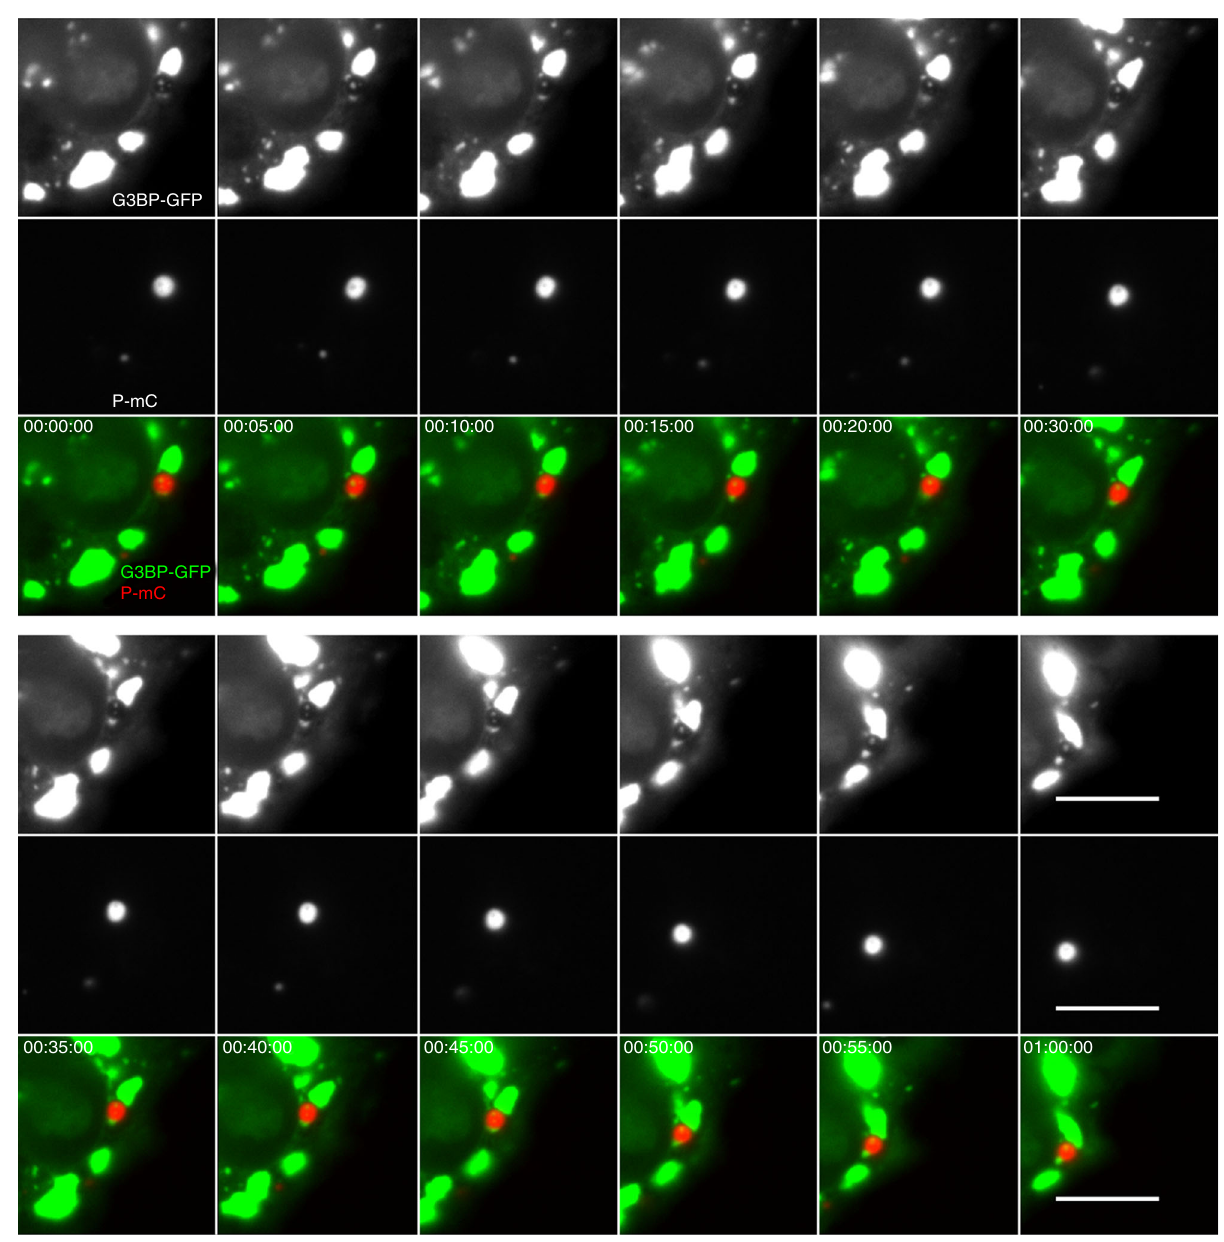
Fig. 3 NBs and SGs are non-miscible liquid organelles. U373-MG cells were transiently transfected with pG3BP-eGFP (to visualize SGs, top row ). 1 h post transfection, they were infected with the recombinant virus rCVSN2C-P-mCherry ( medium row ). Live-cell time-lapse experiments were performed at 16 h p. i. G3BP-GFP signals ( green ) and P-mCherry signals ( red ) are merged in the bottom row . The time post-infection is displayed in the upper left corner of each panel and the scale bars correspond to 10 μ m. Images have been extracted from Supplementary Movie 5 and are shown at 5-min intervals. Note also the mobile, punctate G3BP-GFP-containing structures inside